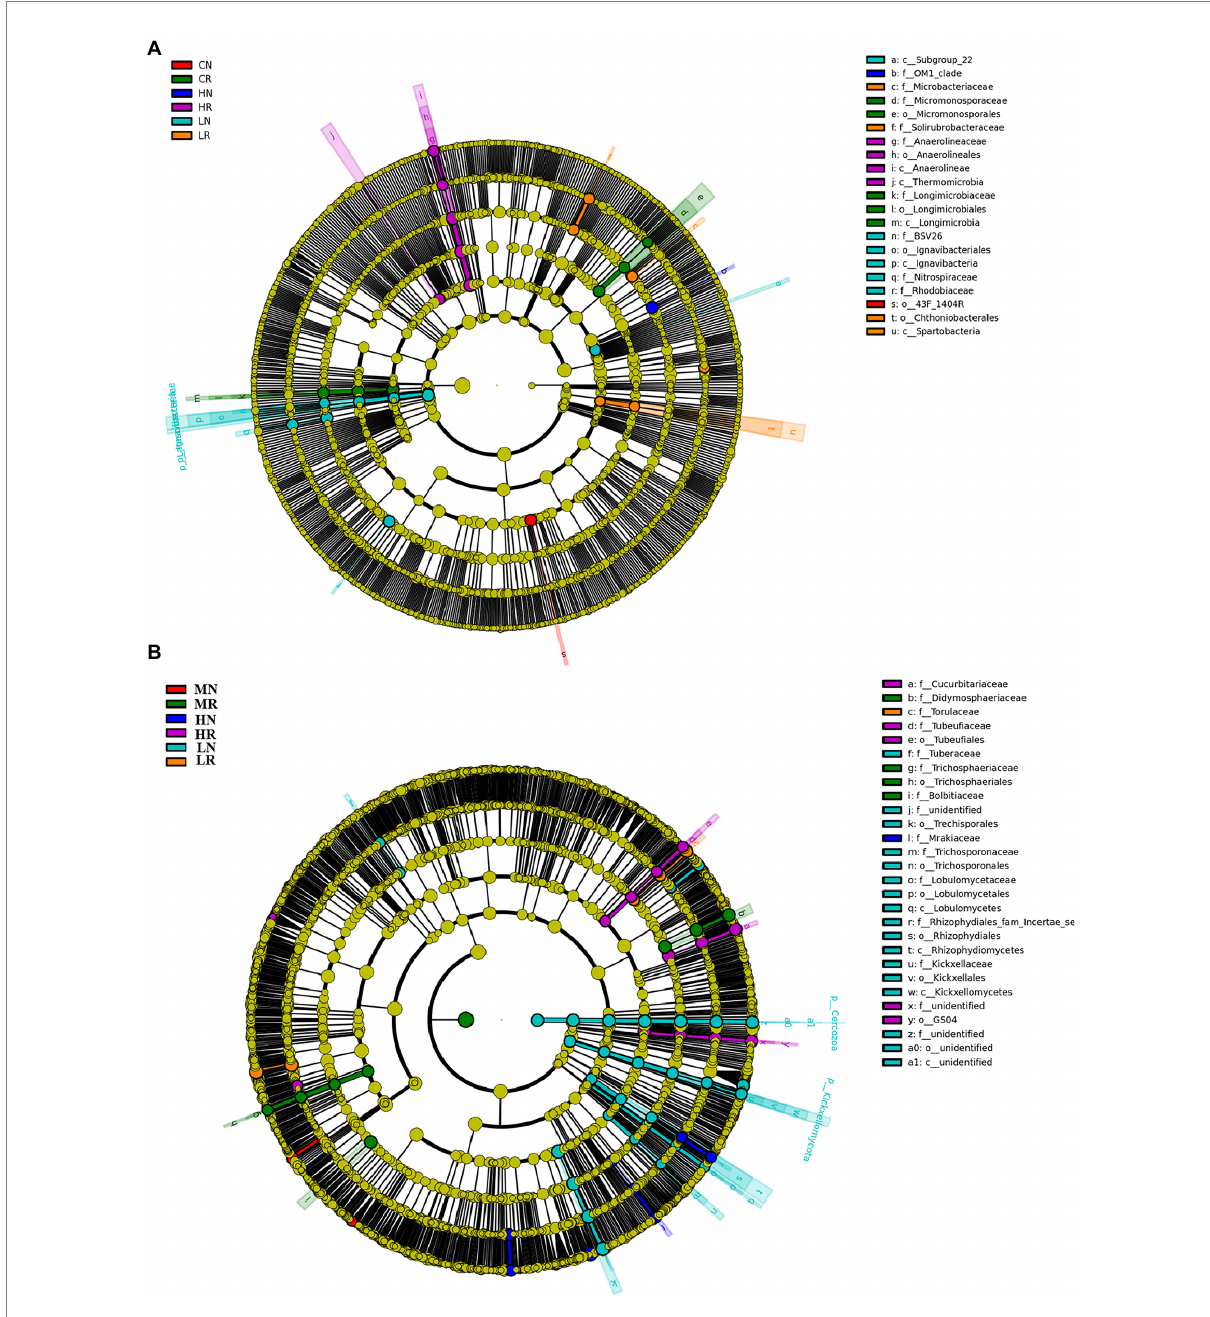
FIGURE 4 Species enriched biomarker diagram associated with each treatment. (A) Bacterial microbial community significantly enriched in each sample; (B) fungal microbial community significantly enriched in each sample. The size of each circle is proportional to the relative abundance of a community. Biomarkers were determined by LDA effect size (LEfSe) analysis, LDA scores >3, p <